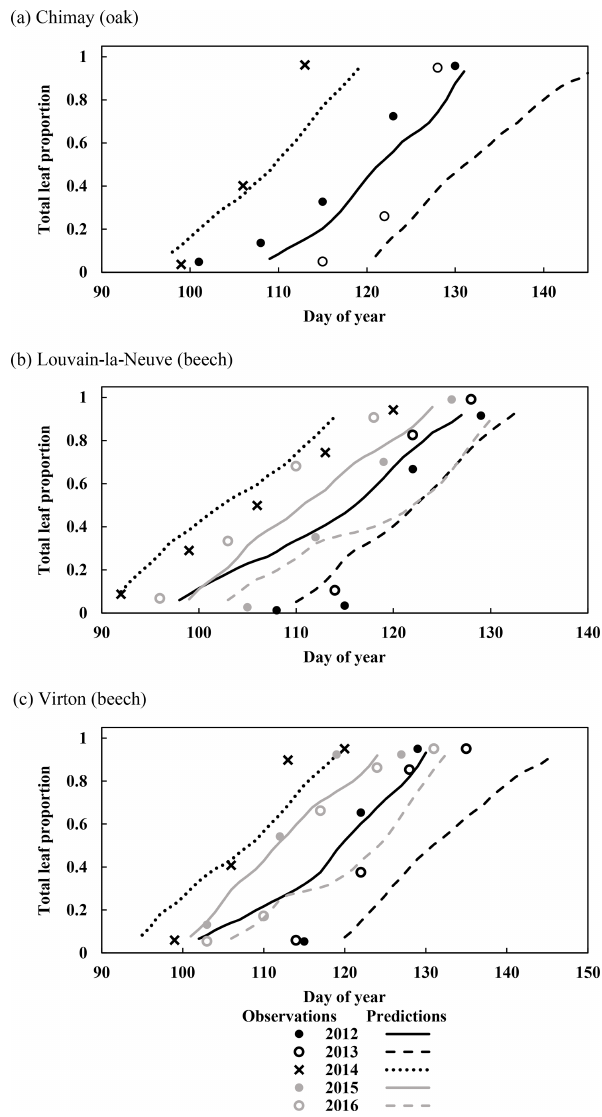
Figure 3. Observed and predicted increase in leaf proportion in Chi- may, Louvain-la-Neuve and Virton during the budburst and leaf de- velopment phase (data from 2012 to 2016). Observations are miss- ing in Chimay for 2013, in Louvain-la-Neuve for 2012 and 2013, and in Virton for